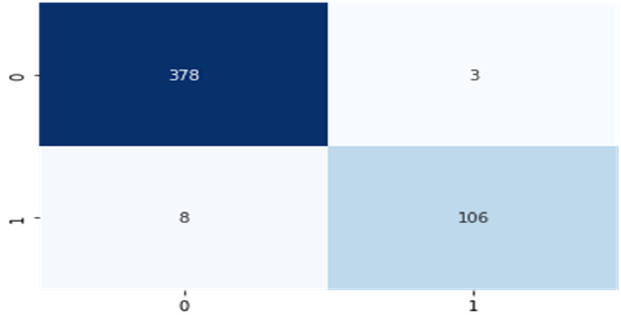
Figure 8. The confusion matrix curve of the hard voting model (GRU-LSTM).